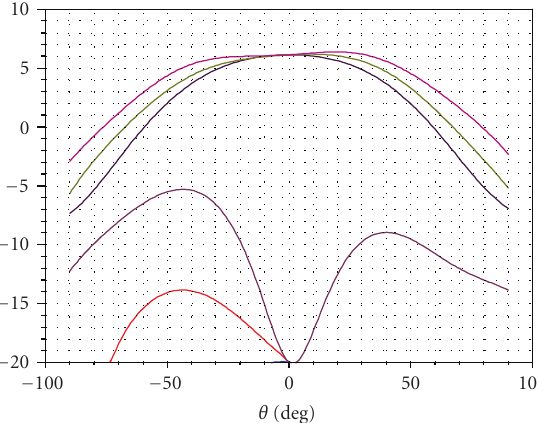
Figure 8: Simulated radiating pattern in transmit.